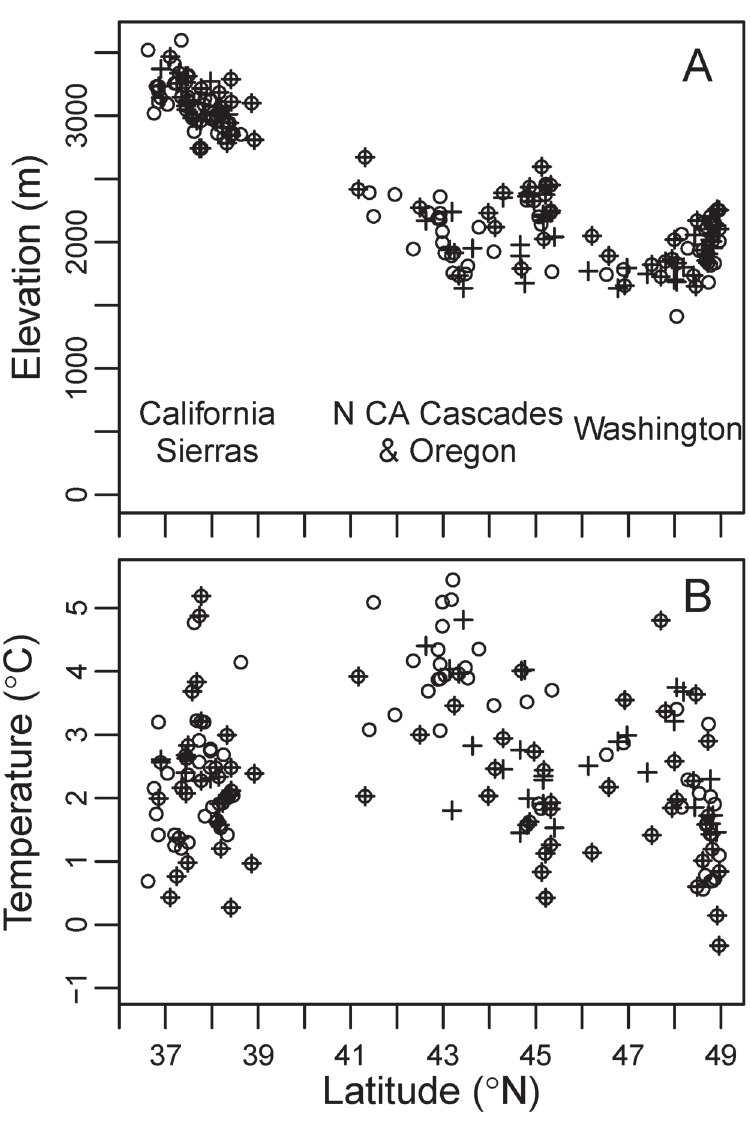
Fig 4. Distribution of plots with Pinus albicaulis . Open circles represent plots with trees, and crosses, plots with seedlings. (A) Elevation and (B) mean annual temperature, as a function of plot